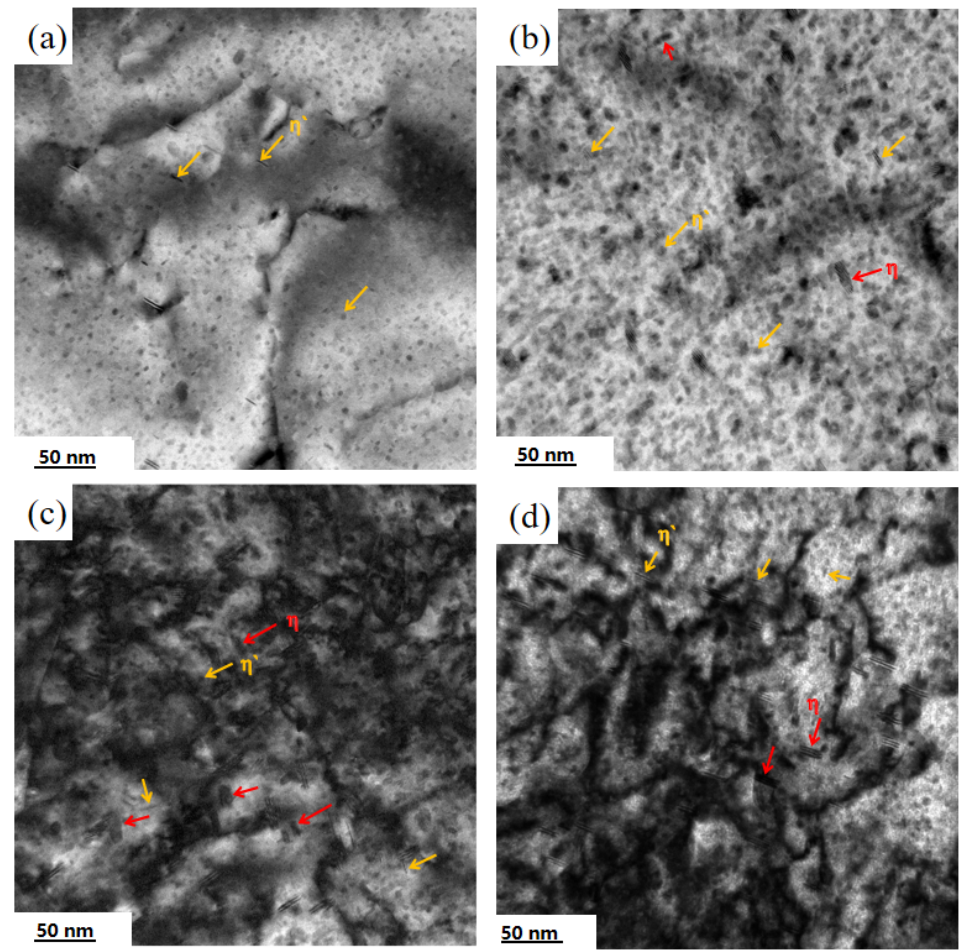
Figure 10. TEM images of the creep aged 7B04-P al alloy under the applied stress of 250 MPa and at 160 °C: ( a ) 1 h; ( b ) 4 h; ( c ) 8 h; ( d ) applied stress of 10 MPa for 8 h. 160 ◦ C: ( a ) 1 h; ( b ) 4 h; ( c ) 8 h; ( d ) applied stress of 10 MPa for 8